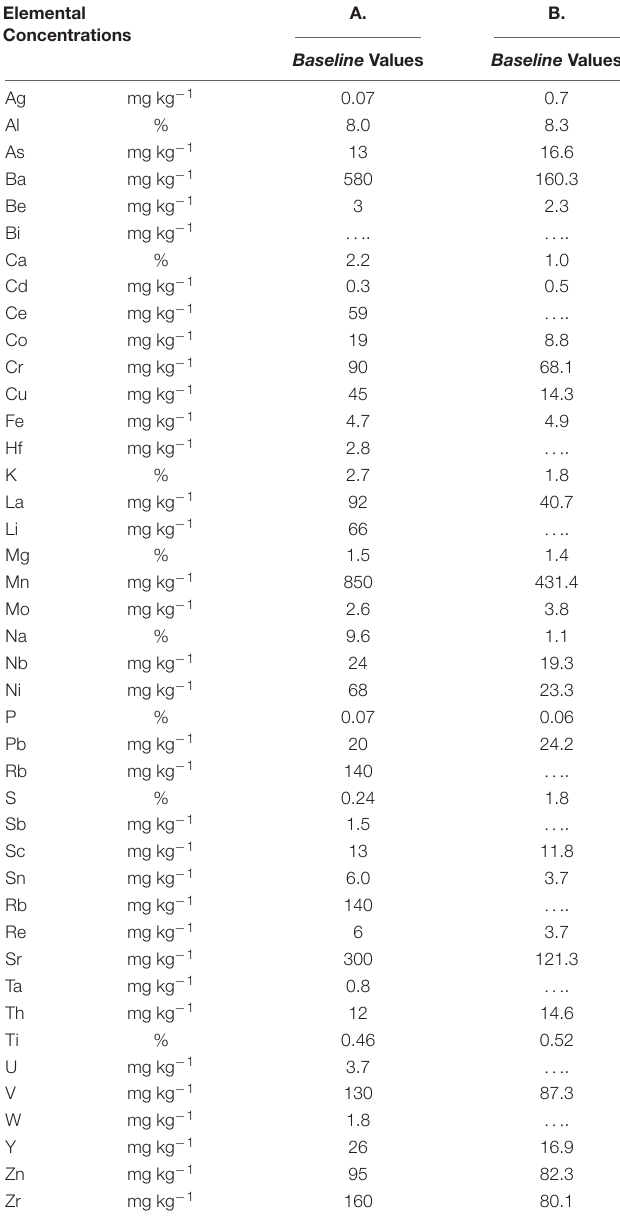
TABLE 1 | Baseline values: (A) Shale (according to Turekian and Wedepohl, 1961); (B) Local to Sepetiba Bay (according to Pinto et al., 2019). Elemental